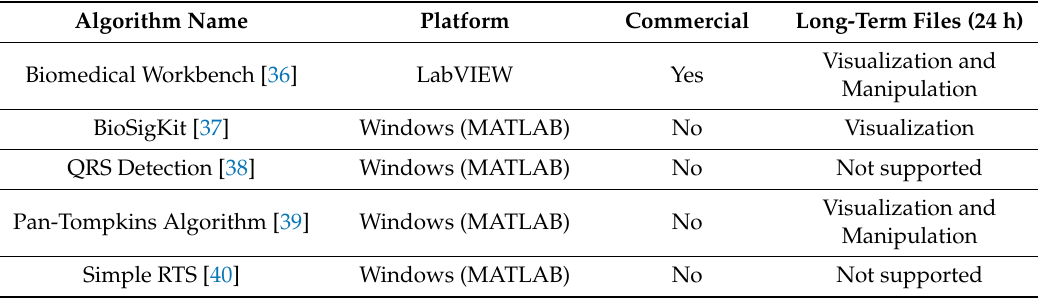
Table 6. O ffl ine algorithms for ECG